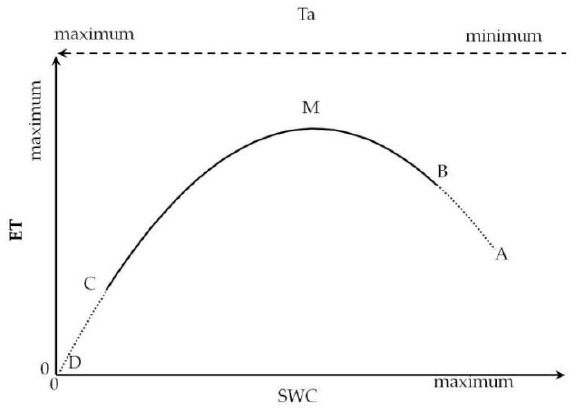
Figure 12. Schematic of ET changing with SWC.